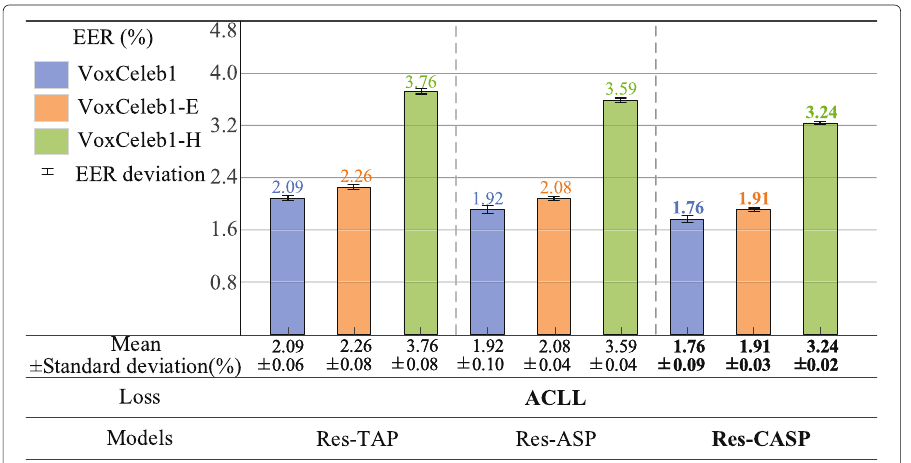
Fig. 7 Text-independent speaker recognition based on Res-TAP, Res-ASP, and Res-CASP models. The ACLL was used as the loss function, and the text-independent speaker recognition were performed on Res-TAP, Res-ASP, and Res-CASP models, respectively